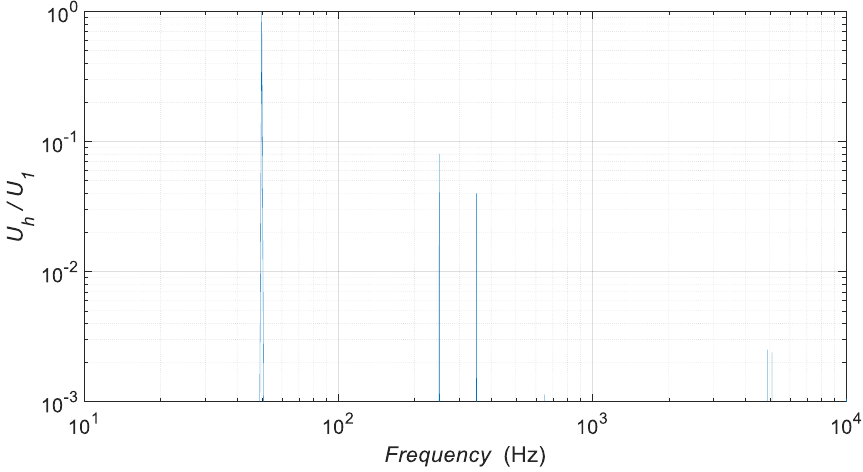
Figure 11. Relative magnitude spectrum of generated line-line voltage.